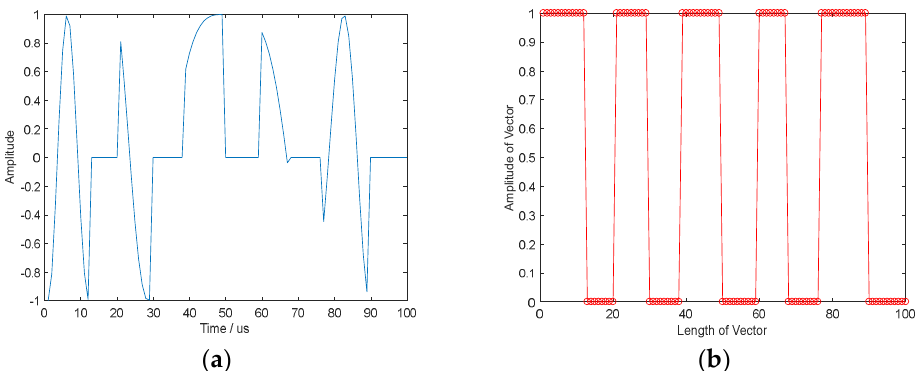
Figure 8. The time − domain waveform of ISRJ and estimated windowed vector with aperiodic train Figure 8. The time−domain waveform of ISRJ and estimated windowed vector with aperiodic train of rectangular pulses. of rectangular pulses. ( a ) The time − domain waveform of ISRJ; ( b ) Estimated windowed ( a ) The time−domain waveform of ISRJ; ( b ) Estimated windowed vector.